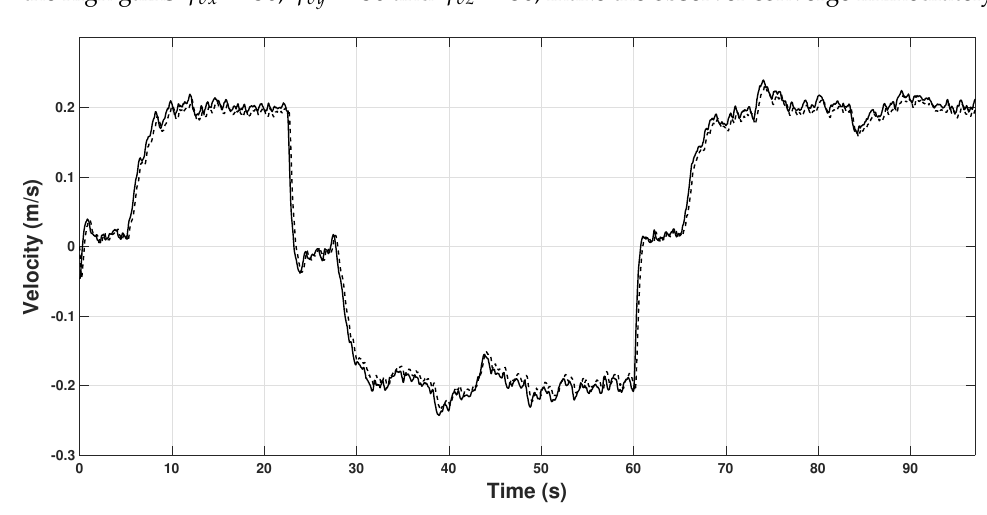
Figure 6. Observed speed on the X b axis. u (continuous line), β 1 x (dashed